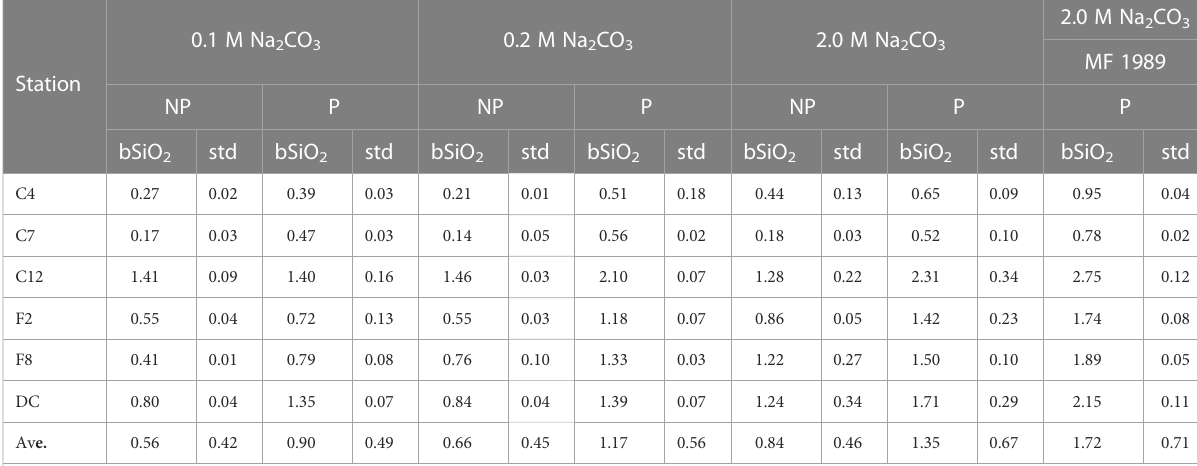
TABLE 3 The bSiO 2 % was determined using 0.1 M, 0.2 M and 2.0 M Na 2 CO 3 (P vs. NP).